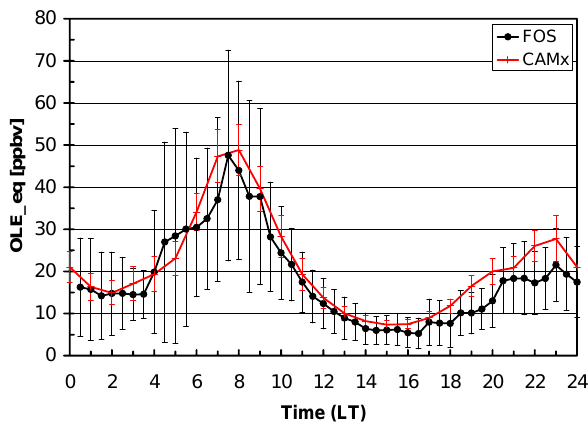
(Fig 4) Fig. 4. Comparison of simulated (in red) and measured (in black) average diurnal variations of propene-equivalent olefin concentra- tions in compound at SIMAT. Error bars represent ± 1 standard de- viations, indicating the inter-diurnal variability. Data were averaged over 10–28 March